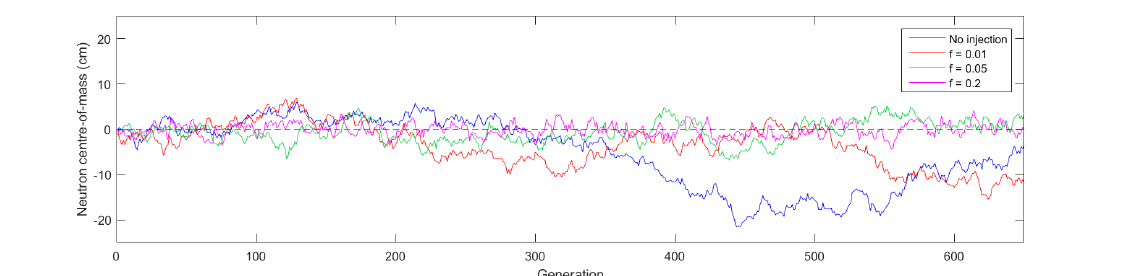
Figure 2: Neutron centre-of-mass for the reflected PWR pin when varying the particle injection fraction